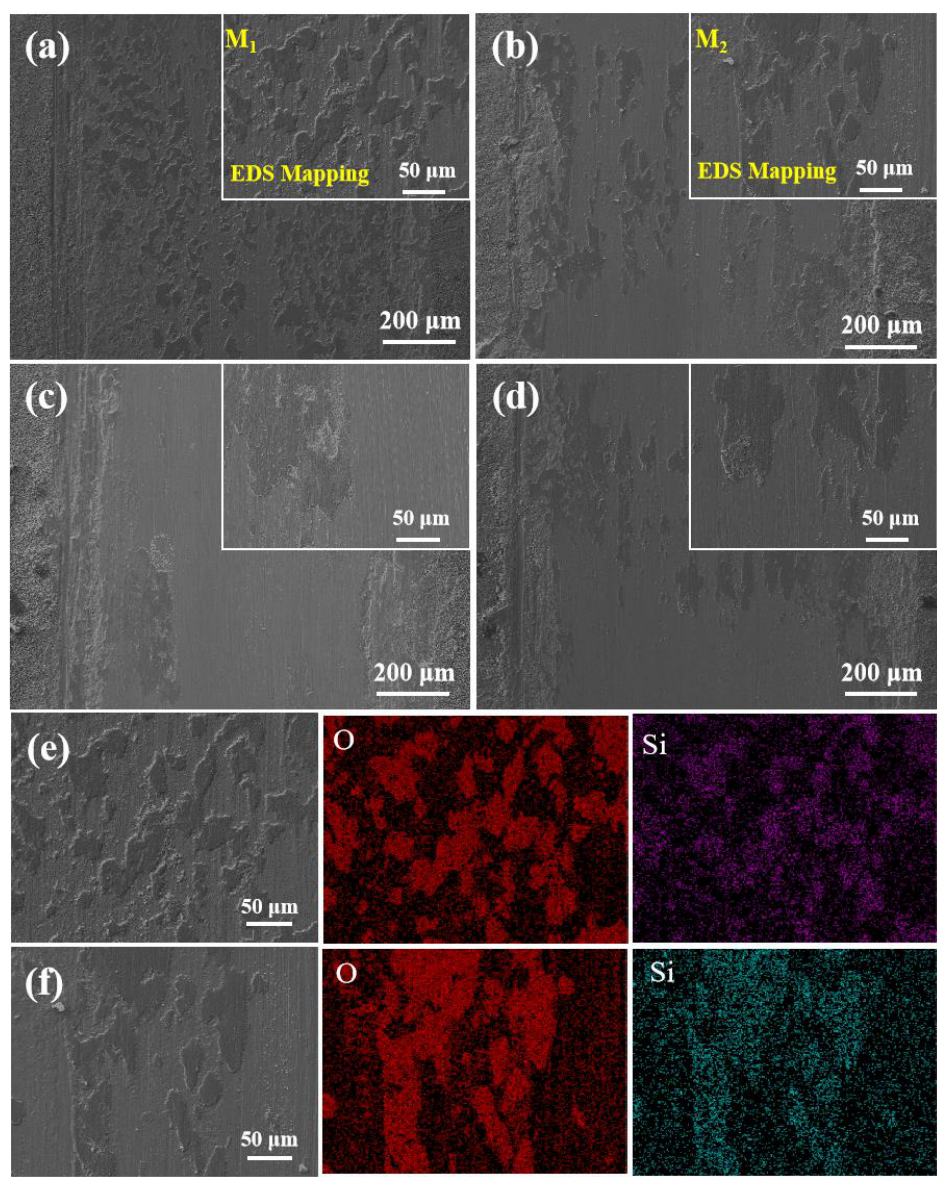
Figure 9. SEM images of the worn-out surfaces of the different samples. ( a ) CHT, ( b ) CT-80, ( c ) SCT- 150, and ( d ) DCT-196. Local magnification of sample with EDS surface scan. ( e ) CHT, ( f ) CT-80.